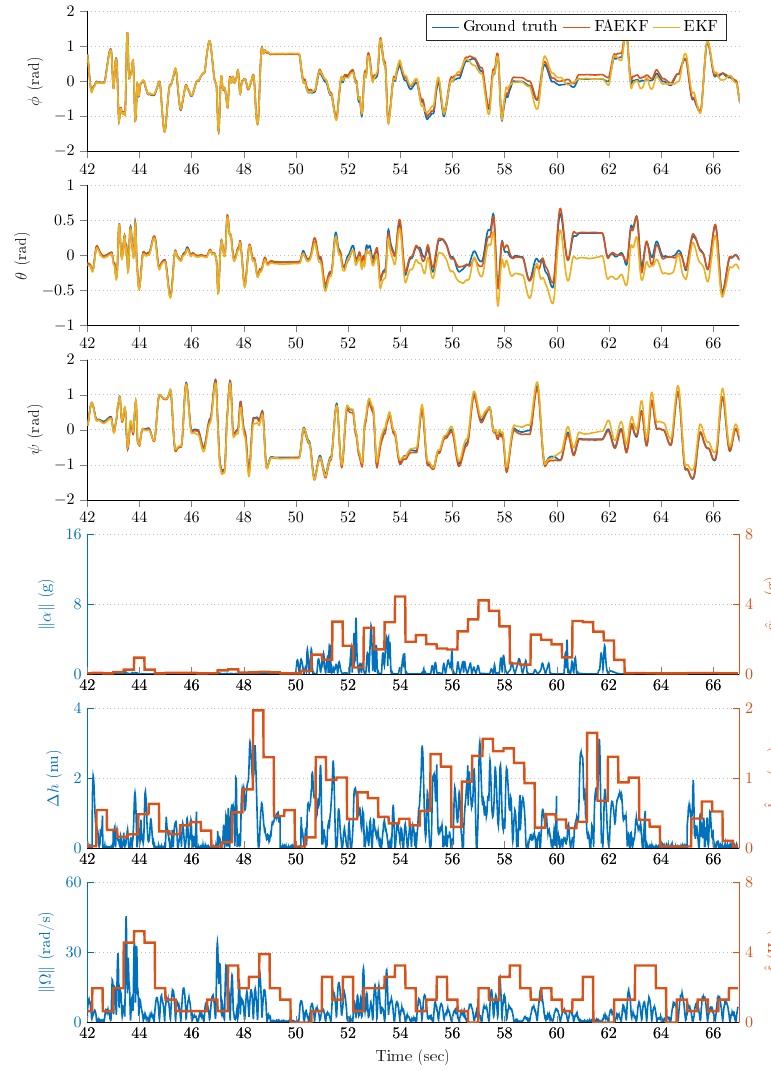
Figure 8. First time slot from the